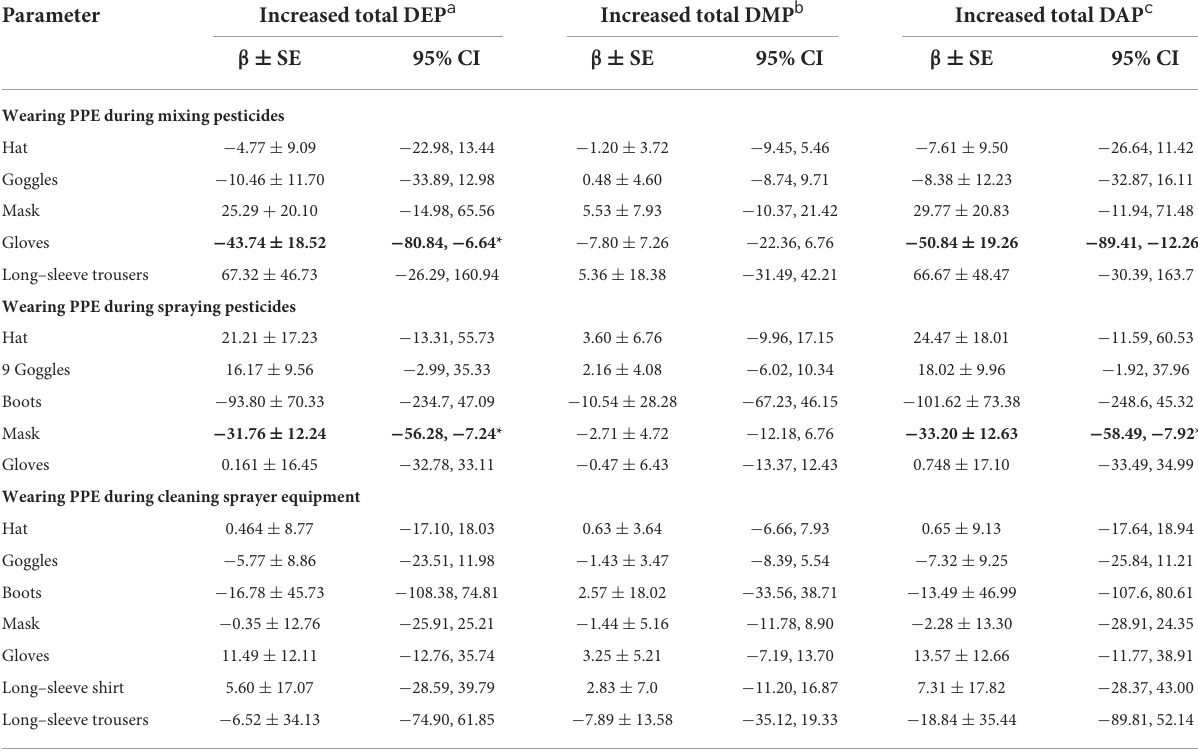
TABLE 4 Factors of PPE use on increased urinary OP metabolite levels during pesticide application.